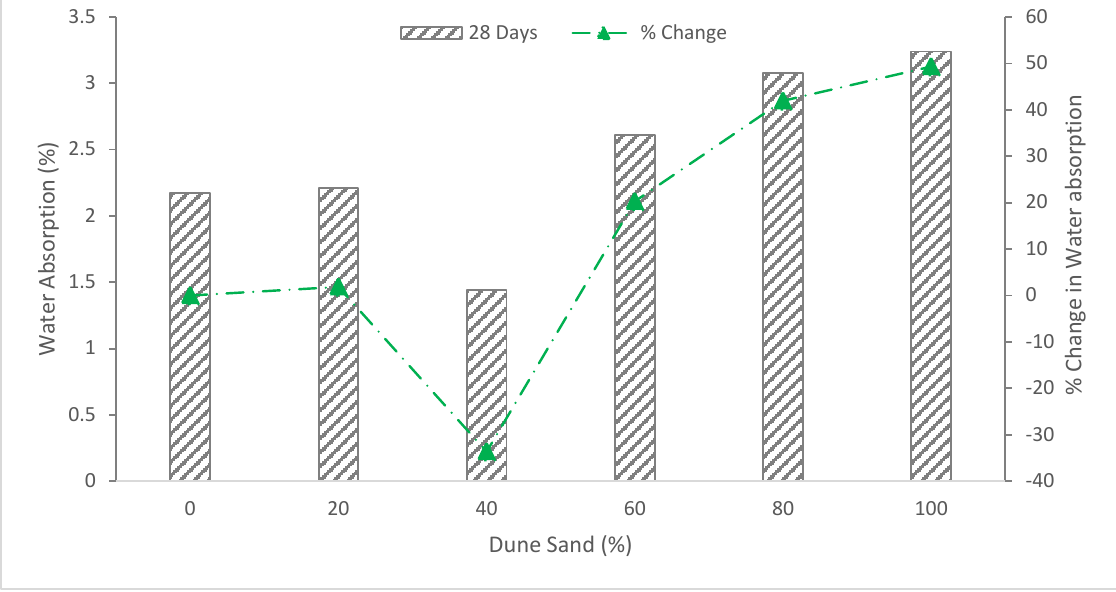
Figure 10. Water absorption: data source [40].